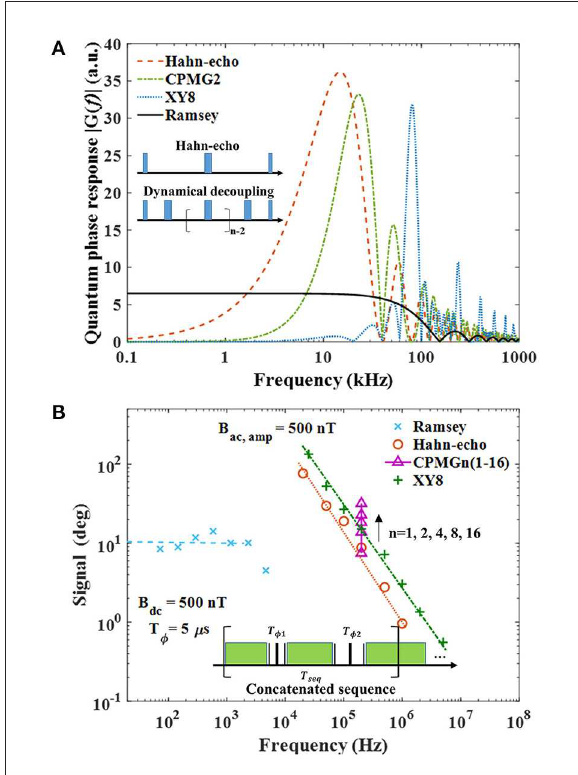
FIGURE4 (A) Filter functions of different pulsed sequences that can be used in NV-magnetometry. In the calculation of the filter function of the Ramsey sequence, the sensing time T φ In the calculations of the sequences for ac field sensing, i.e., Hahn-echo, CPMG2, and XY8, the sensing time T φ An overview of the measured frequency responses of NV-magnetometry using the different sequences. The QPSD technique is used to read out the field strength by extracting the quantum phase measured by the sequences. The “ response of the Ramsey sequence, of which the bandwidth is limited by the sampling rate in the experiment. The “ “ ” shows the ac field responses regarding different T φ when ◦ Hahn-echo and XY8 are applied for the measurements. The “ shows the measurements of a 200 kHz signal by CPMG sequences with different numbers of the π -pulses. One of the primary goals of the NV-magnetometry development is to develop concatenation of the sequences that can ensure a flat frequency response for ac field